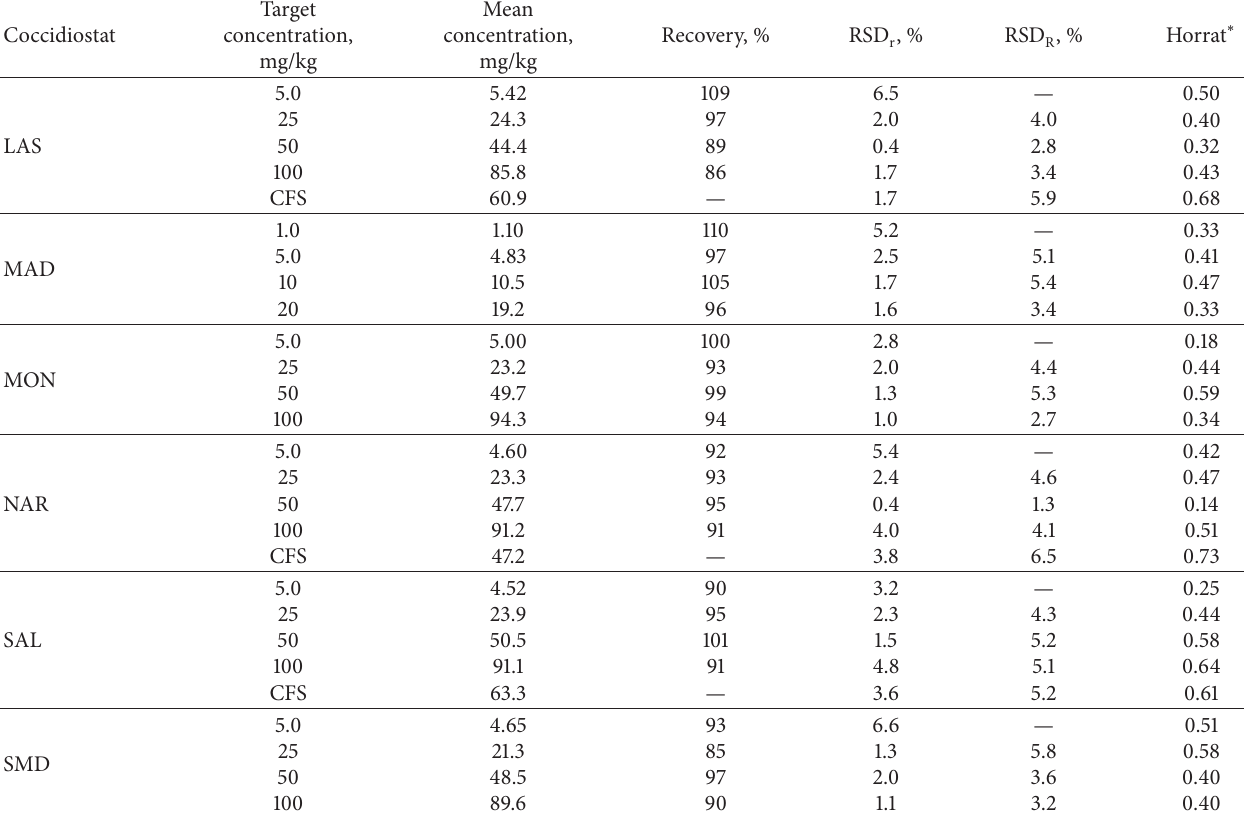
Table 3: The results of in house validation: recovery and precision of the determination of six ionophore coccidiostats in feed samples. Coccidiostat